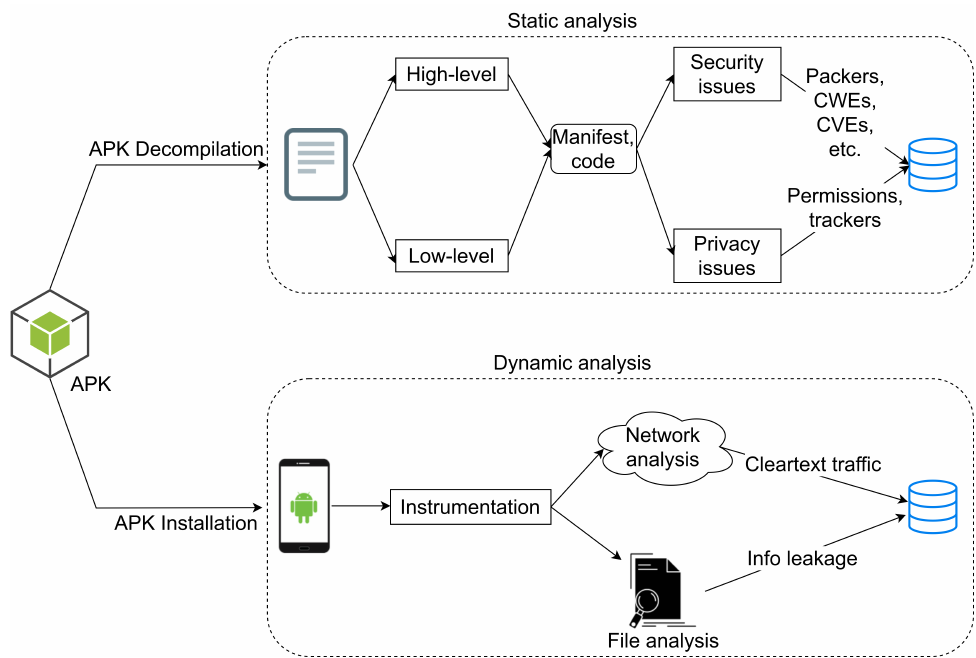
Figure 1. Overview of the followed